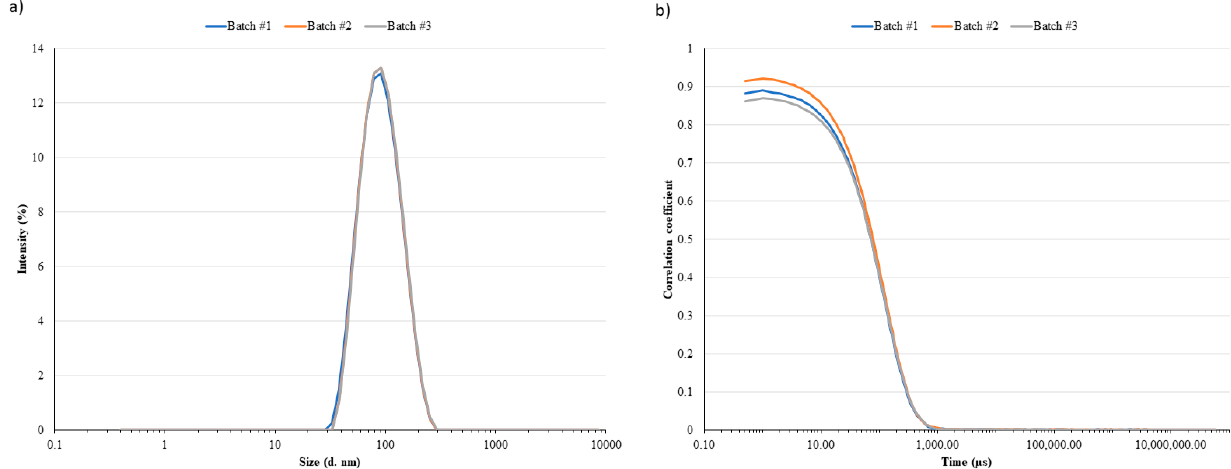
Figure 2. Aliquots of Comirnaty from three different batches were analyzed by Dynamic Light Scattering (DLS) to determine the hydrodynamic diameter based on the intensity distribution curve. ( a ) Samples were monodispersed, and the height of the peak signal overlapped. ( b ) These considerations were also supported by the correlogram plots. Table 2. Impact of storage and mechanical stress on the particle size distribution of LN expressed as the ratio of hydrody- namic diameter (D h ), which is calculated based on the main peak of DLS data, and polydispersity index (PDI) before and after the applied experimental condition. DLS: Legend of symbols expressing a variation <10% (=); 10–25% (+); >25% (++); NTA: p -values of Student’s T -test of particles before and after the applied experimental condition. n.d.: not